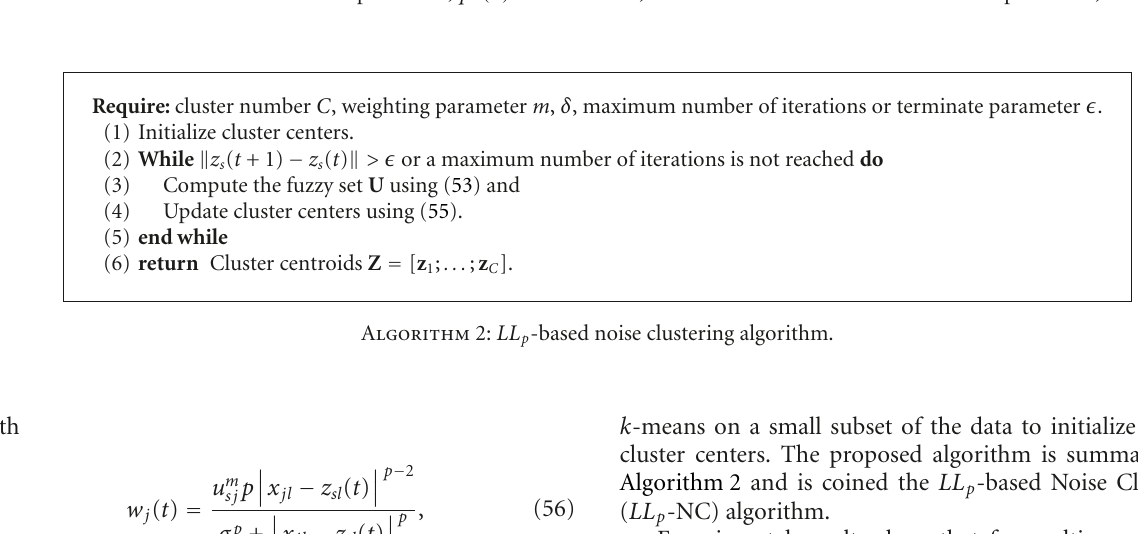
Figure 8: Comparison of Lorentzian BP with BPD and OMP for impulsive contaminated samples. (a) Contaminated p -Gaussian, σ 2 = 0 . 01. R-SNR as a function of the contamination parameter, p . (b) α -stable noise, σ = 0 . 1. R-SNR as a function of the tail parameter, α .